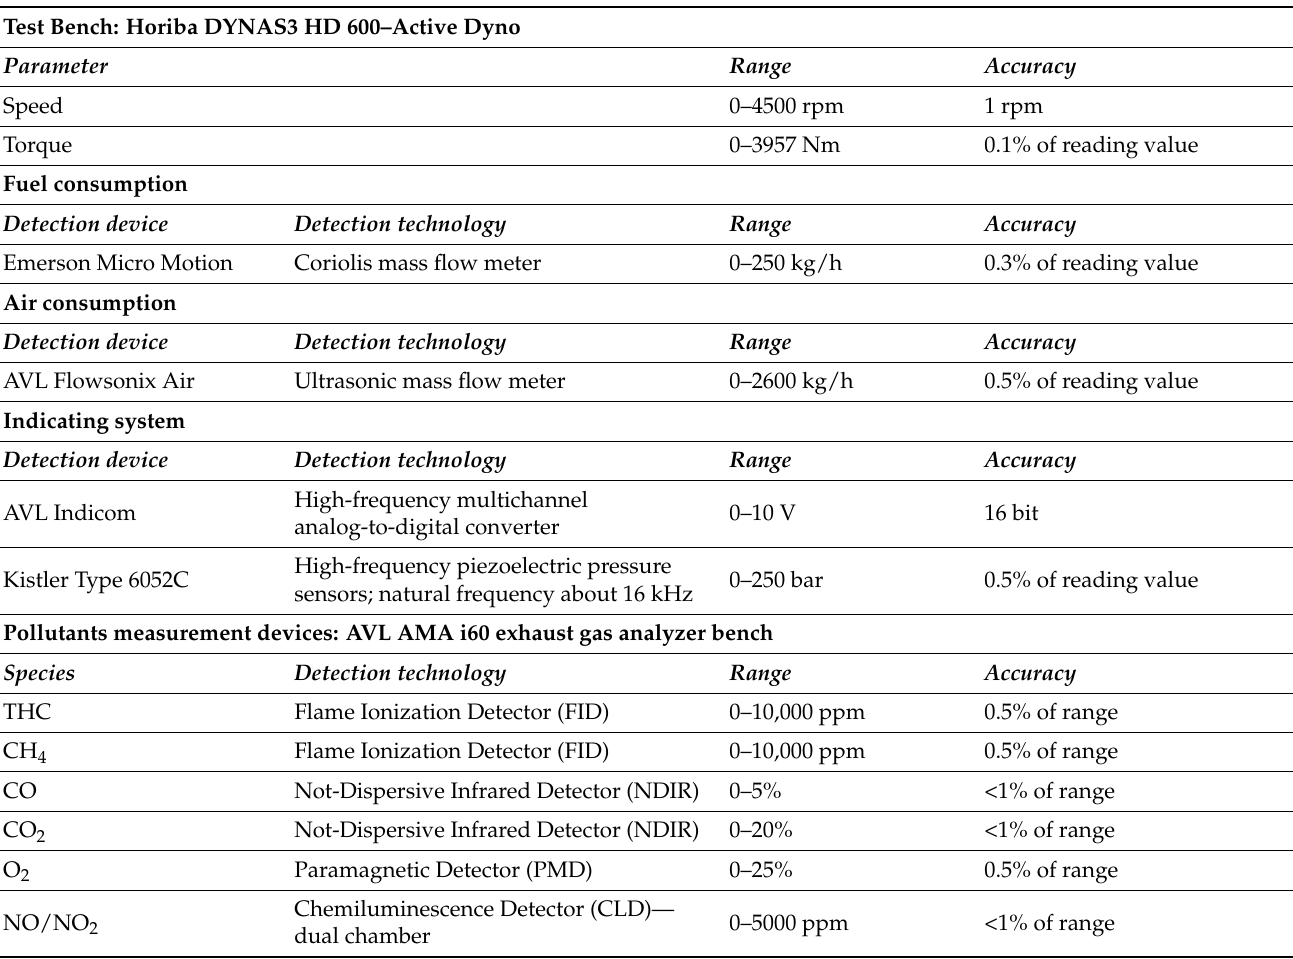
Table 2. Main characteristics of the test bench and main test cell measuring